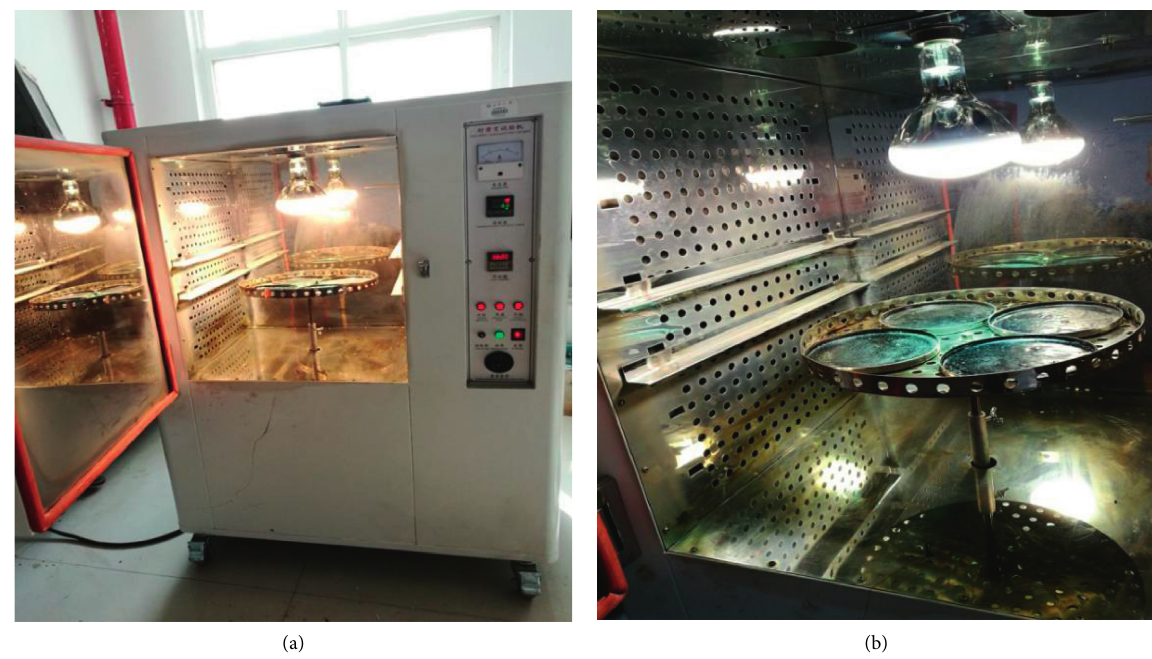
Figure 5: Yellowing resistance aging box: (a) appearance of the box; (b) internal